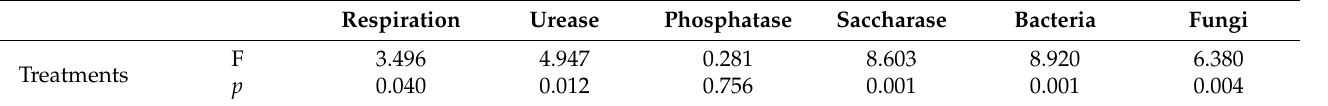
Table 4. Correlation analysis between different chlorothalonil applied concentrations and soil respira- tion, enzymatic activities, and culturable microorganisms. Respiration Urease Phosphatase Saccharase Bacteria Fungi F Treatments